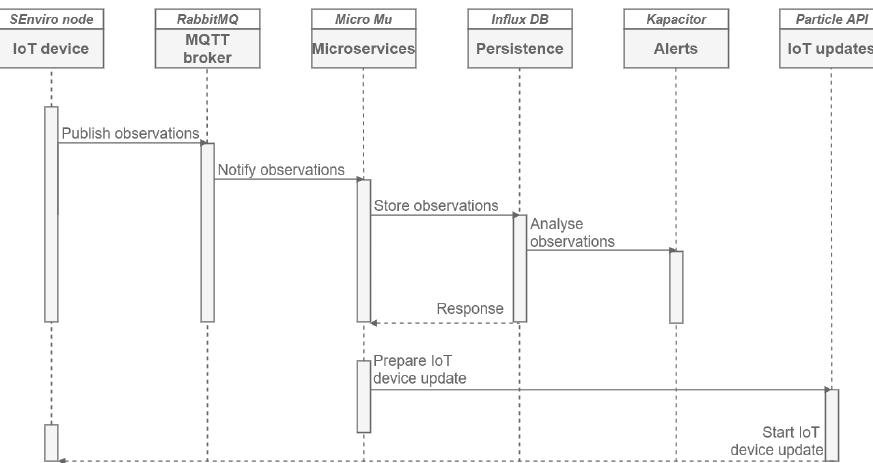
Figure 6. A sequence diagram from the IoT node